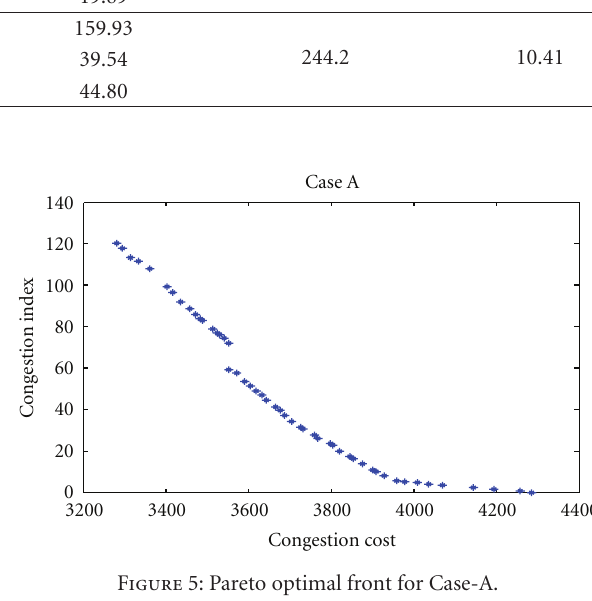
Figure 5: Pareto optimal front for Case-A.